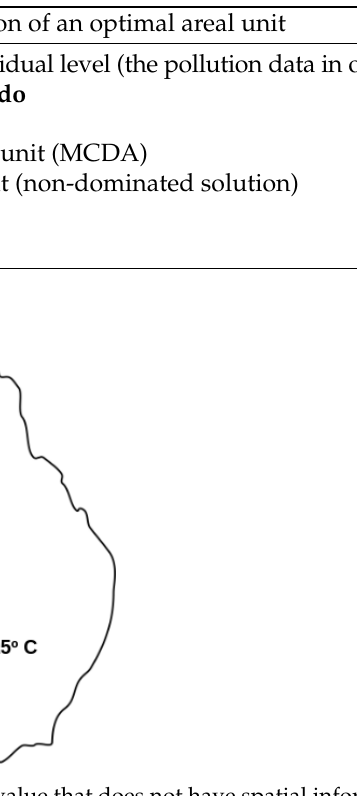
Figure 1. Example of the need to estimate a value that does not have spatial information